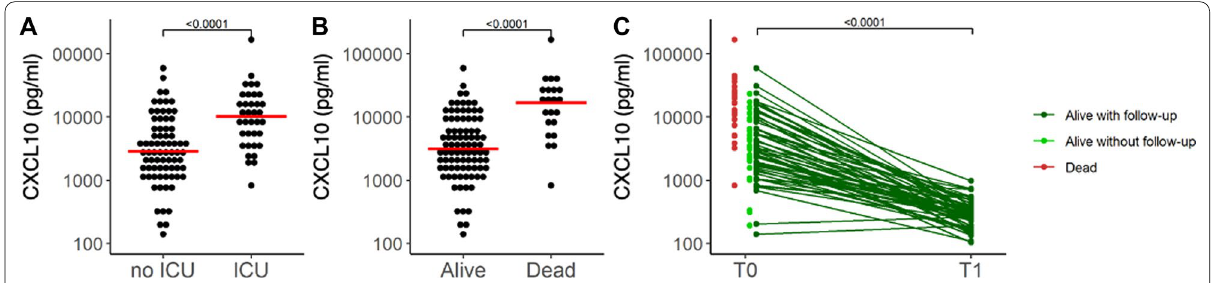
Fig. 5 CXCL10 levels (pg/mL) in logarithmic scale of patients: A without and with ICU care (n and 22, respectively), and C alive with a follow-up (n